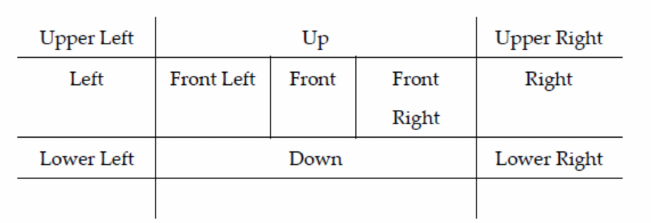
Figure 5. A total of 11 head orientations were assigned in 9 classes. Each head orientation was assigned to a different class but the three head orientations “Front Left”, “Front”, and “Front Right” were assigned to a single class, namely